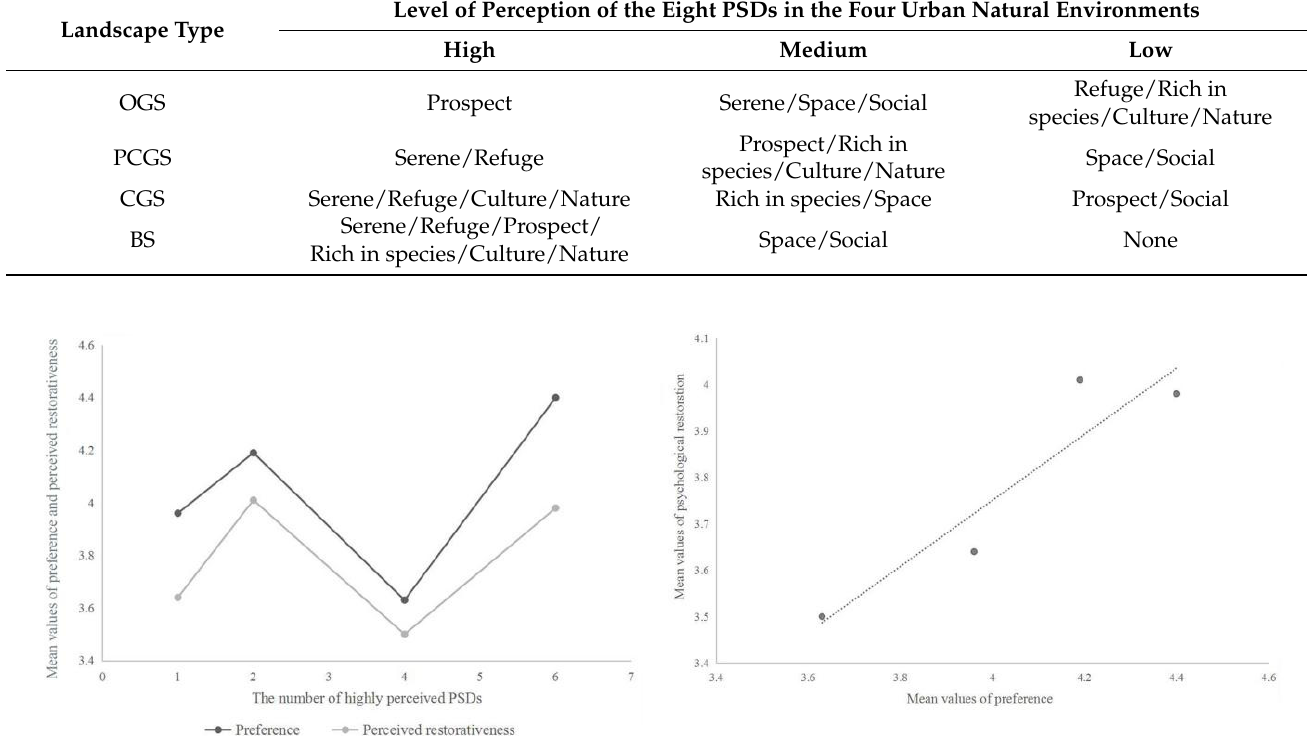
Figure 5. The relationship between the number of highly perceived PSDs, preference and psychological restoration.